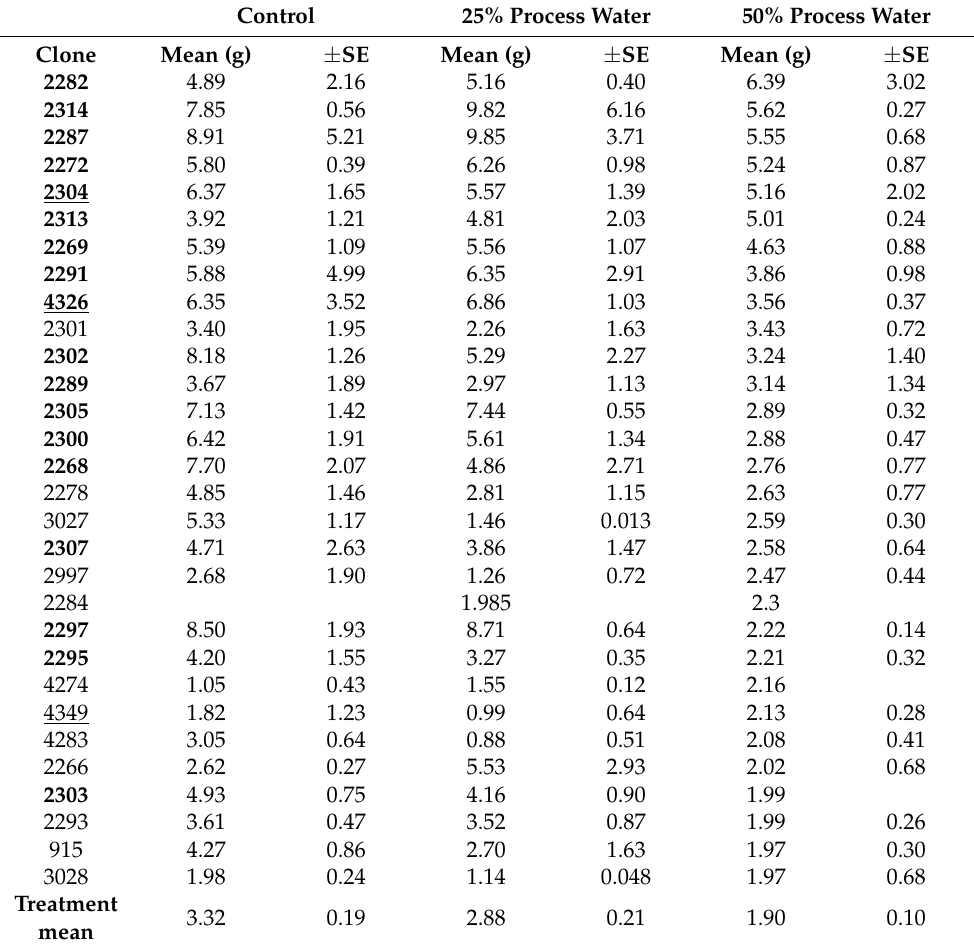
Table A2. Mean total biomass ( ± SE, grams) of the top 30 balsam poplar clones in the 50% process water treatment with corresponding means ( ± SE) for the control and 25% process water treatments in 2013. Clone numbers in bold identify clones that ranked in the top 30 for all three water treat- ments, while underlined clone numbers indicated consistent performance in both years’ experiments. Periods indicate dead plants.